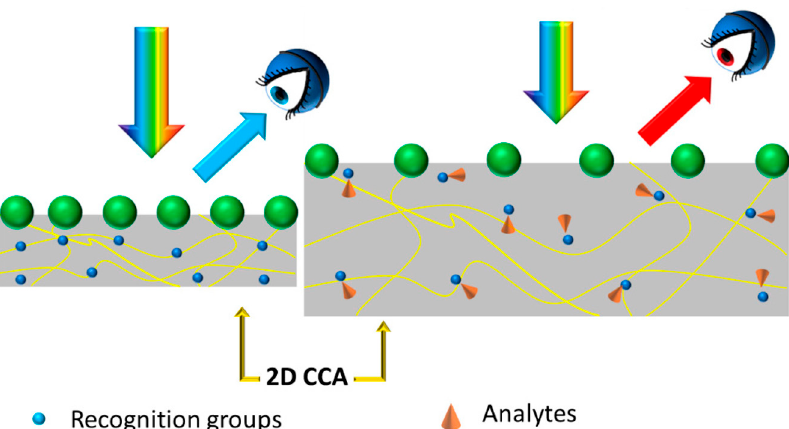
Figure 5. Working principle of the 2D colloidal crystals arrays (CCA) as responsive chromatic sensor: In this specific case, the interaction between analytes and recognition groups produces a swelling in the responsive material, inducing a modification of the particles spacing, and therefore a variation in the diffracted wavelength. Adapted with permission from [39].